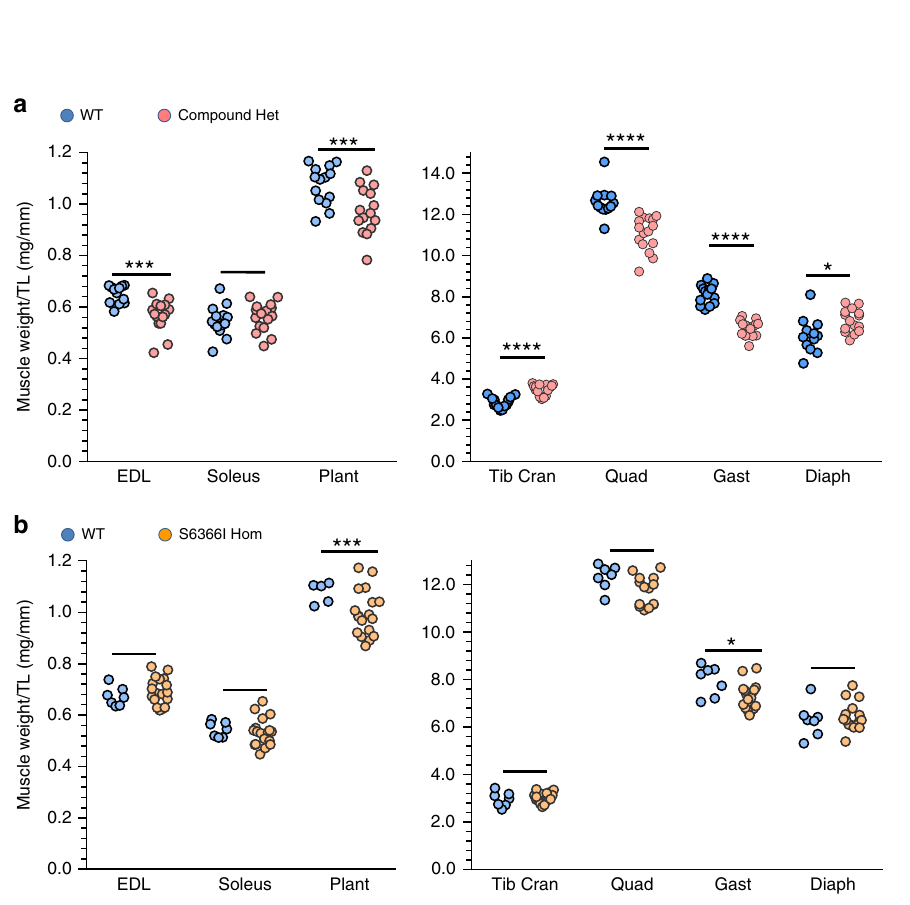
Fig. 1 Basic characterization of the mouse strains. a Top: Nebulin localizes to the thin fi lament of the skeletal muscle sarcomere. Bottom: The structure of mouse nebulin with the S6366I site indicated (in super-repeat 22, orange) and the Δ Exon55 site (in super-repeat 9, pink). A mouse was created with compound heterozygous Neb mutations: one missense mutation in exon 106 (Neb S6366I ) and one in-frame deletion of exon 55 (Neb Δ exon55 ), the Neb S6366I/ Δ exon55 , or Compound-Het for short. b When breeding Het Neb S6366I parents, genotypes of offspring follow Mendelian genetic ratios (top) and when breeding Het Neb S6366I with Het Neb Δ exon55 parents (bottom), offspring also closely follows Mendelian genetics. c Body weight vs. days-of-life. Gompers non-linear least squares fi t with as null hypothesis that one curve fi ts all data sets. Test (Sum-of-squares F-test) reveals that the null hypothesis is rejected ( p ≤ 0.0001; F (DFn, DFd): 63 (3,341)). (Results of male mice are shown with similar results found for female mice (not shown).) d Tibia length is reduced in Compound-Het and Neb S6366I homozygous 4 months old male mice. An ordinary one-way ANOVA without matching or paring was performed with a posthoc multiple testing comparison with multiple testing correction (Sidak). * p = 0.02; ** p = 0.008. e Grip strength in Compound-Het and Neb S6366I mice, 1, 4 and 10 mo of age. A two-way ANOVA (no matching) reveals a signi fi cant effect of age and genotype on grip strength but without interaction. A posthoc multiple testing comparison with multiple testing correction (Dunnett) reveals a signi fi cant grip strength reduction at all 3 ages in Compound-Het mice and a signi fi cant reduction in 10 mo old Neb S6366I mice. ** p < 0.01; **** p < 0.0001. f In 3 mo old male mice (left) Compound-Het mice have a 35% decreased maximal lower limb force and Neb S6366I Hom have a 7% reduction. In 10 mo old male mice (middle) the reduction is 37% and 18% and in 10 mo old female mice (right) the reduction is 37% and 18%. Non-linear least squares fi t to Hill curve with as null hypothesis that one curve fi ts all data sets. Test (Sum-of-squares F-test) reveals that the null hypothesis is rejected in each panel (****p ≤ 0.0001; F (DFn, DFd): 104.2 (8,208)). g Relative force-frequency relation (same data as in f, left) shows a left shift for both the Compound-Het and Neb S6366I Hom mice with increased relative force at the shown frequencies of 40 and 60 Hz (One-way ANOVA without matching or paring performed with a posthoc multiple testing comparison with multiple testing correction (Sidak). **** p < 0.0001. Inset: decreased frequency for ½ maximal force in Compound-Het mice. Ordinary one-way ANOVA without matching or paring. A posthoc multiple testing comparison with multiple testing correction (Sidak). * p = 0.02. Number of mice in b 291 (top) and 668 (bottom); c, d : WT: 21, Compound-Het: 18, and NebS6366I Hom: 16; e 1 mo 19, 14, 12; 4 mo: 22, 18, 12; 10 mo 14, 6, 10. f left and g : WT: 9, Compound-Het: 7, and Neb S6366I Hom: 6; f middle: WT: 6, Compound-Het: 2, and NebS6366I Hom: 6; f right WT: 6, Compound-Het: 4, and Neb S6366I Hom: 3. g Inset 9 WT mice, 6 Compound-Het mice and 7 Neb S6366I Hom mice. Bar values are mean ± SEM. Source data are provided as a Source Data fi